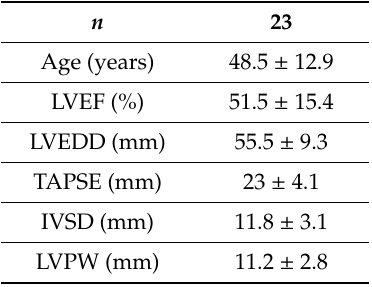
Table 1. Control Group Patient Characteristics and Echocardiographical